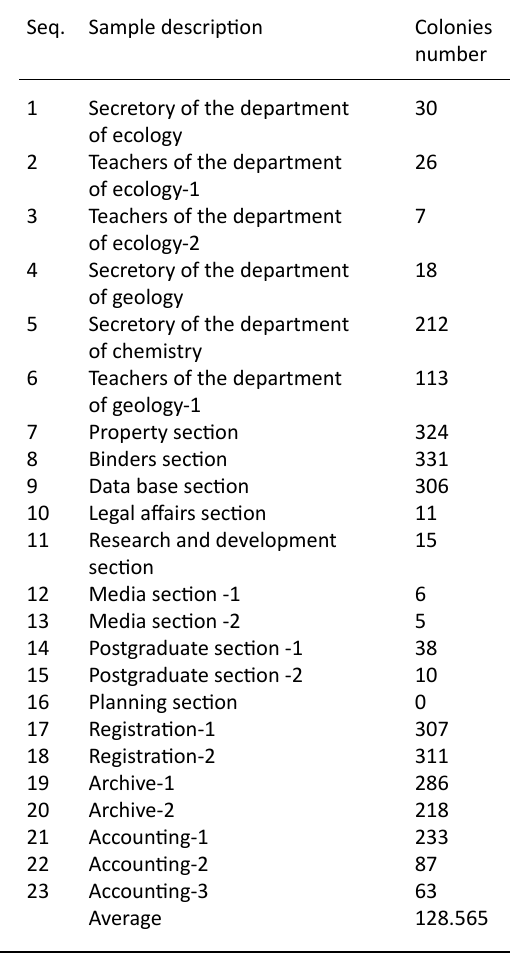
Table 5. Bacterial contamination of computer keyboards Seq. Sample description